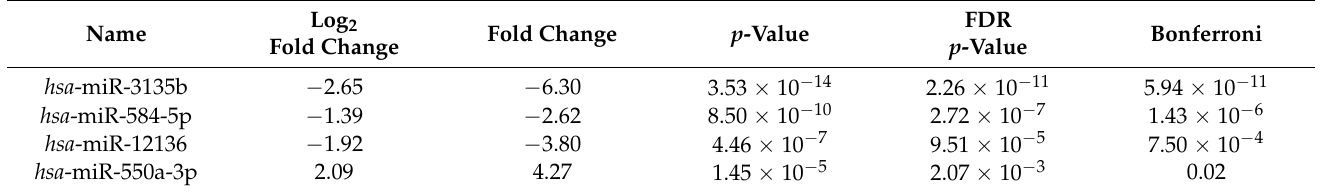
Table 1. Differential expression analysis. Differentially expressed miRNAs ( hsa -miR-3135b, hsa - miR-584-5p, hsa -miR-12136, and hsa -miR-550a-3p) with a Bonferroni corrected p -value ≤ 0.05 and fold-change FC ≥ 2.0.